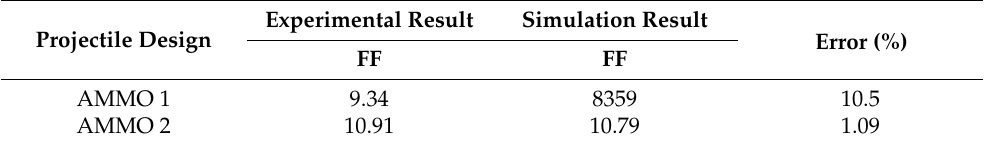
Table 6. Frangibility factor value